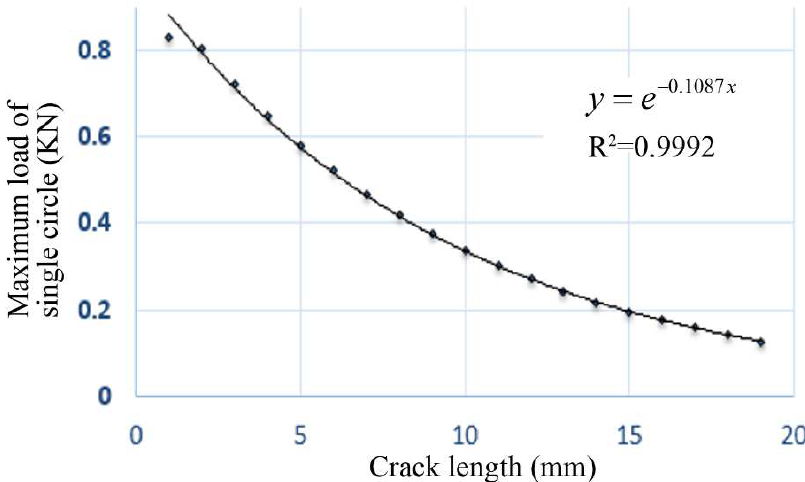
Figure 9. Normalized curve between the maximum load of a single circle and crack length. According to Equation (3), the relationship between the maximum load of a single circle and number of load cycles and the relationship between the maximum load of a single circle and crack length have been obtained. Therefore, the relationship curve between crack length and the number of load cycles is also obtained, as shown in Figure 10.